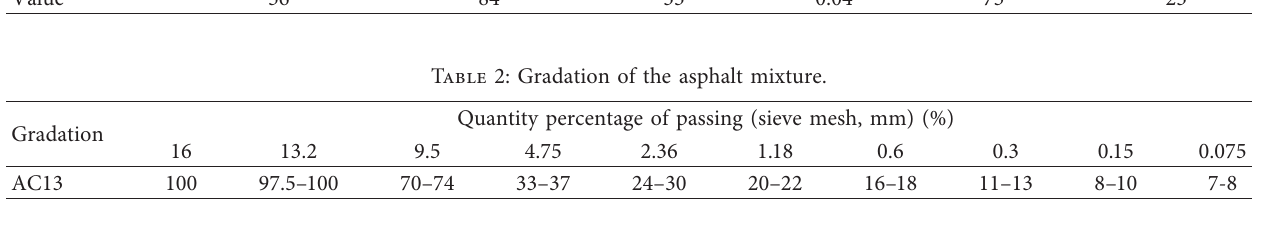
Table 3: Performances of SBR-modified emulsified asphalt.